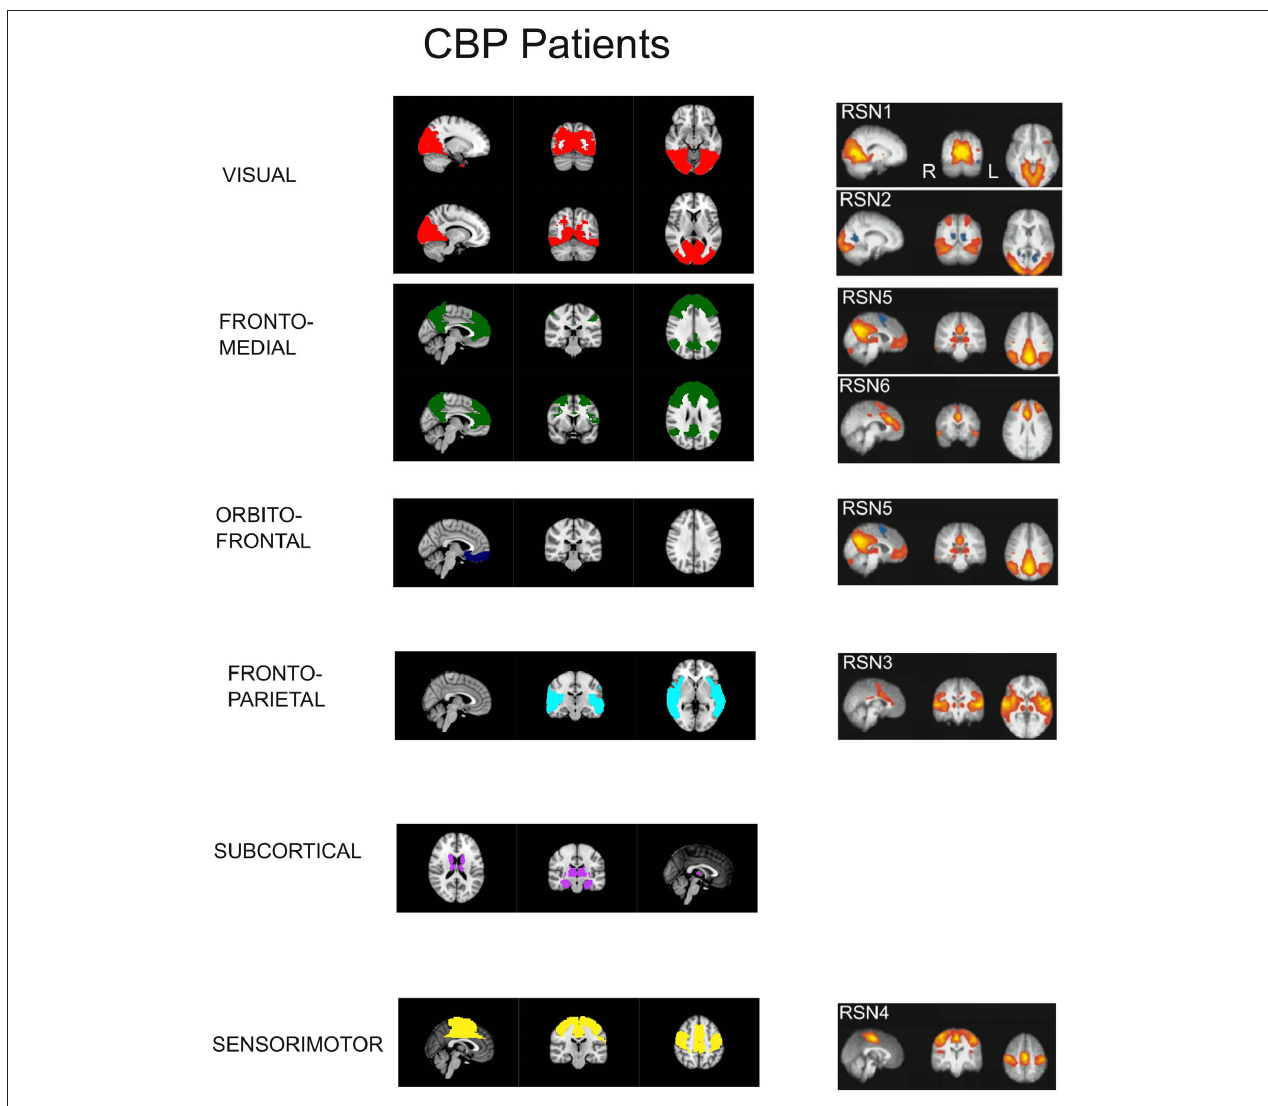
Figure A2 | Communities found in chronic back pain group (CBP) compared with resting state networks obtained from probabilistic component analysis in Beckmann et al. (2005) . These regions, associated with specific cognitive functions, are labeled as follows: RSN1 (medial areas of